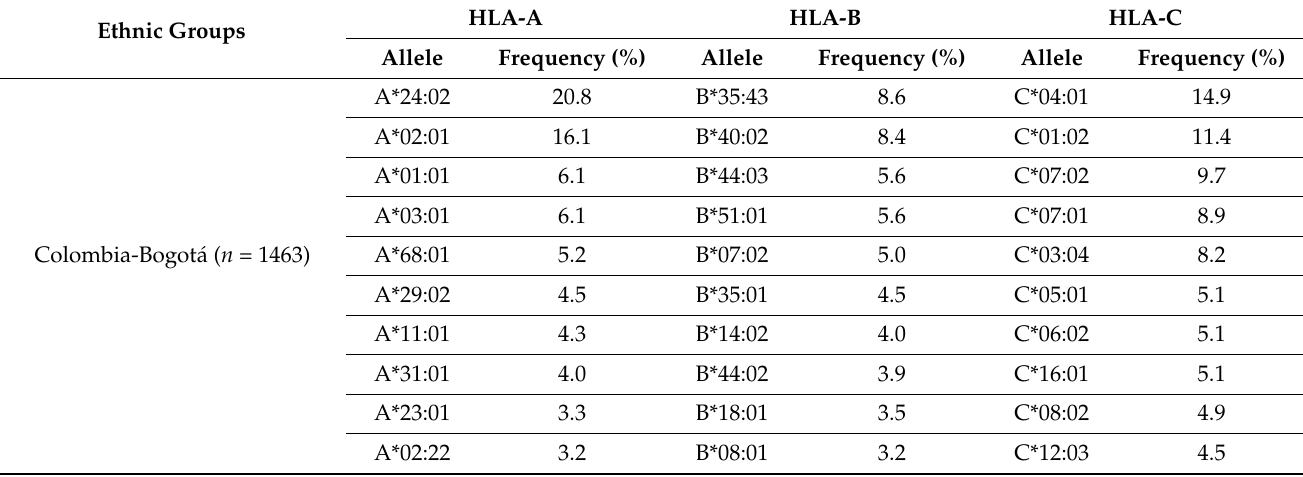
Figure 1. PRISMA flow diagram of the systematic literature search of the frequencies of the alleles HLA class I (HLA I) and HLA class II (HLA II) in the the Colombian population by using PubMed, Web of Science and Science Direct, as well as the Allele Frequency Net Database (AFND). The number of records ( n ) represent the number of articles, which may contain multiple datasets. Each dataset is defined by a unique combination of: population and reference as usually presented in the grid format of AFND. Table 5. Top 10 most frequent HLA-A, HLA-B and HLA-C alleles in the general population of Colombia according to data obtained from the Allele frequency net database (AFND) [28] (date consulted: 24 February 2021). Abbreviations: n , sample